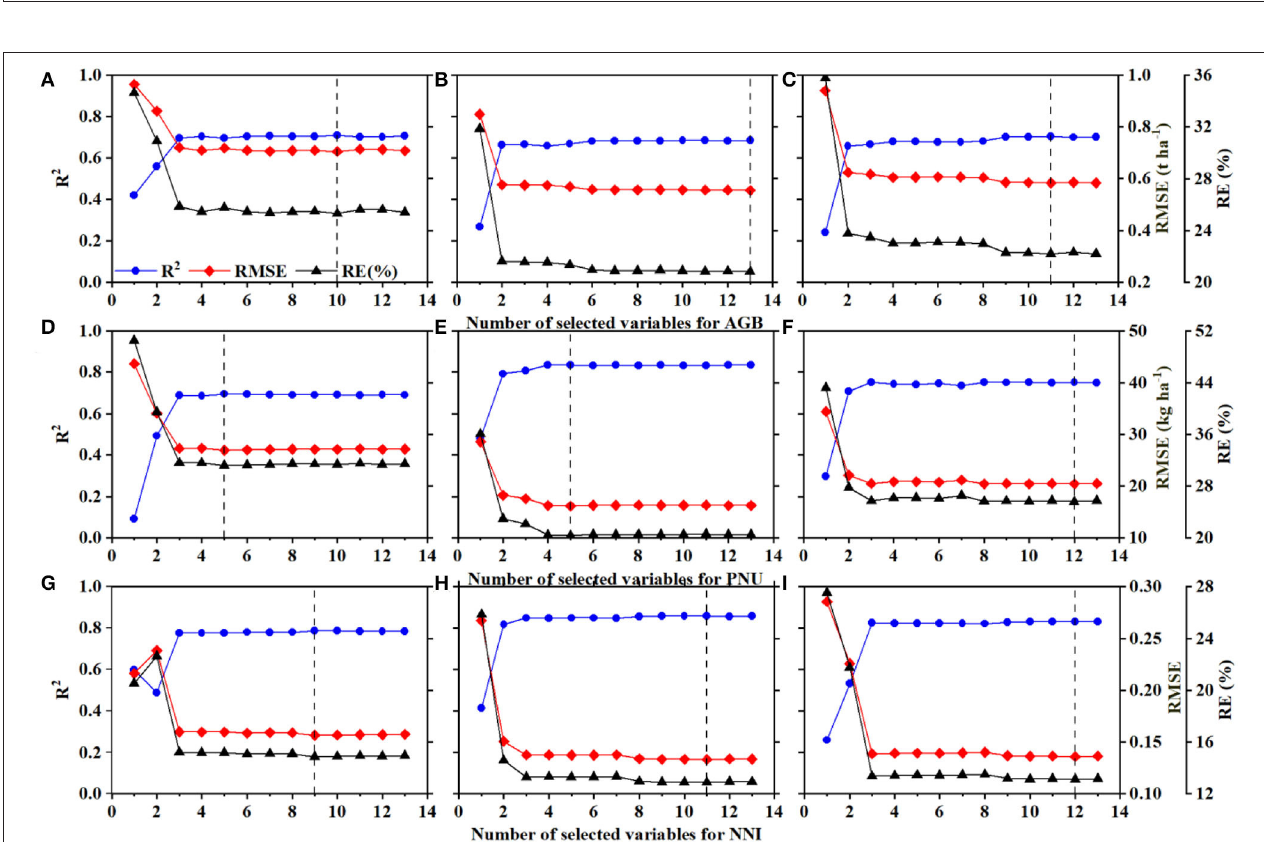
FIGURE 6 | The accuracy of aboveground biomass (AGB), plant N uptake (PNU), and N nutrition index (NNI) with variables selected by the random forest regression in agro-ecological zone 1 (A,D,G) , agro-ecological zone 2 (B,E,H) and across two agro-ecological zones (C,F,I) .